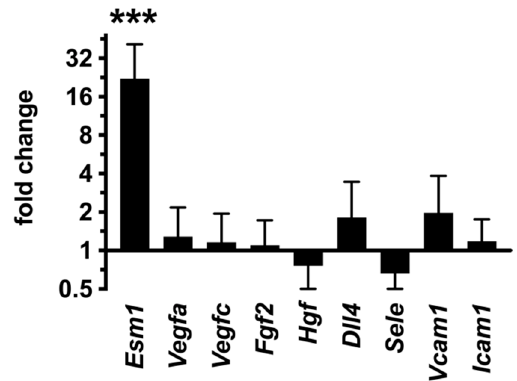
Figure 13. Expression of the tip cell marker Esm1 is increased in dnPKA iEC mice. While the expression of Esm1 was strongly increased in the liver of dnPKA iEC mice, none of the other tested angiogenic factors ( Vegfa , Vegfc , Fgf2 , Hgf and Dll4 ) was affected. In addition, markers of inflammatory-activated endothelium ( Sele , Vcam1 and Icam1 ) were not increased. Mice (males and females) were injected with tamoxifen at the age of 30–35 days and dissected at the age of 61–84 days. Here, 7 control (Tg( Cdh5-cre/ERT2 ) 1Rha without floxed transgenes) and 9 dnPKA iEC mice from three different litters were analyzed. Shown are means ± SD. Data were analyzed using one-way ANOVA followed by Tukey’s multiple comparison test. ***, p < 0.001.